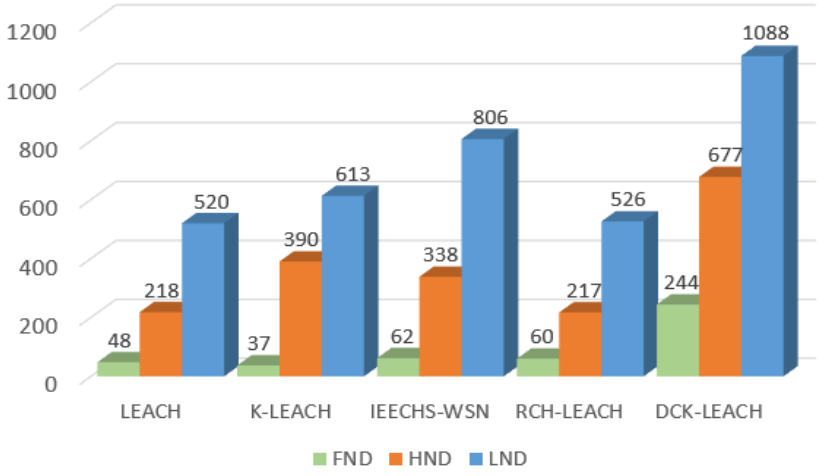
Figure 9. Comparison FND, HND, LND of DCK-LEACH and four other algorithms.